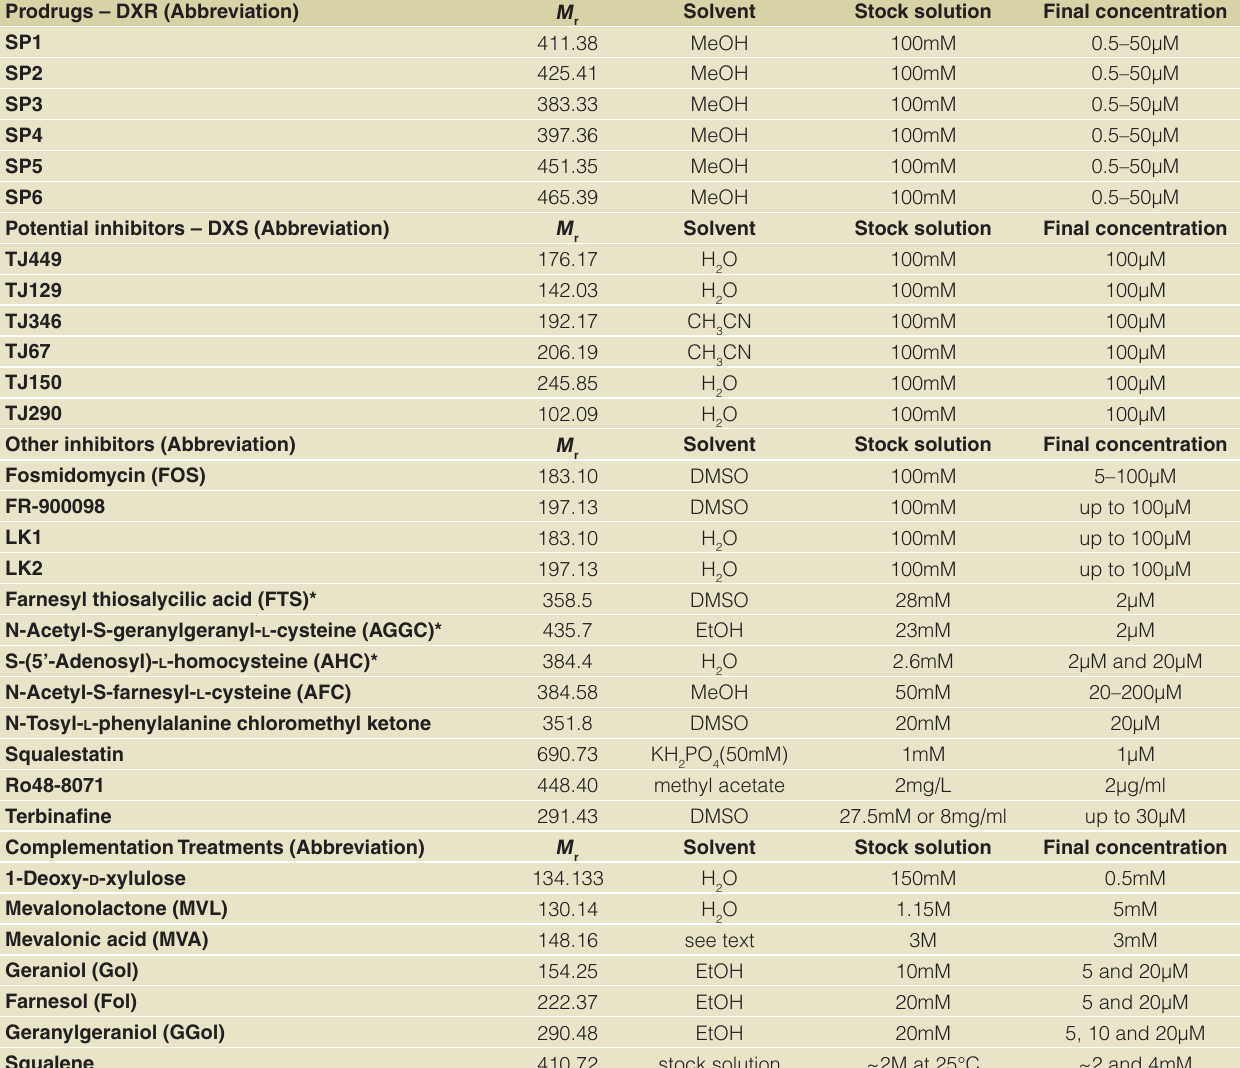
Table 1. List of inhibitors and other compounds used in this